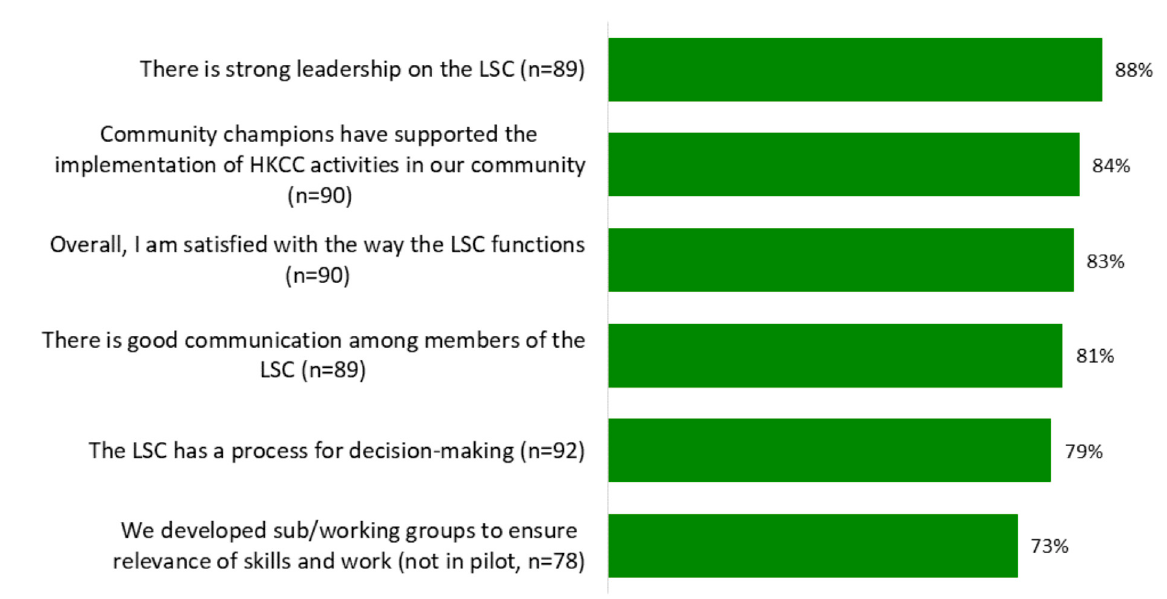
Figure 2. Understanding the local steering committee, as reported by survey respondents.